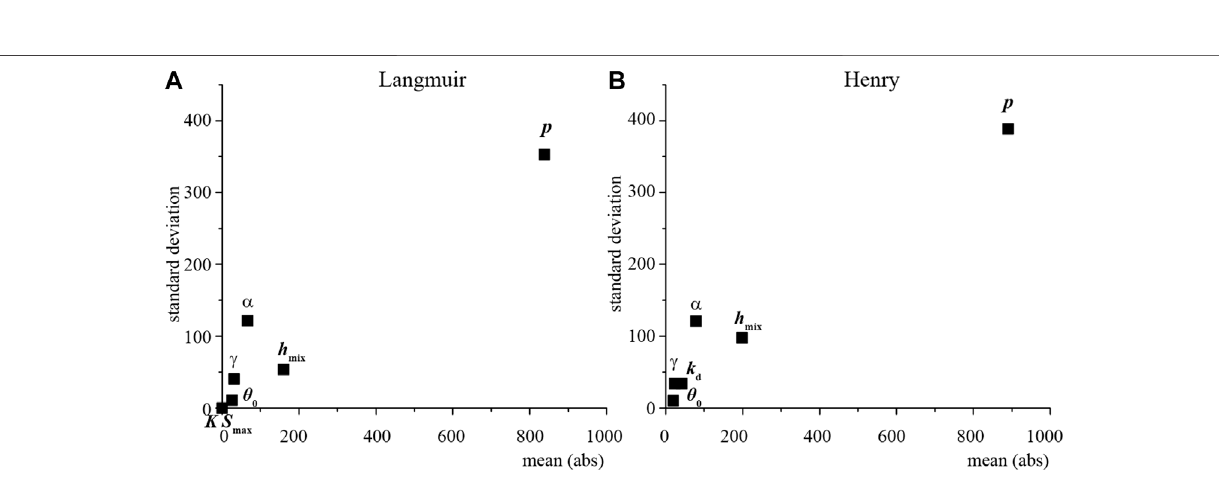
Frontiers in Environmental Science |